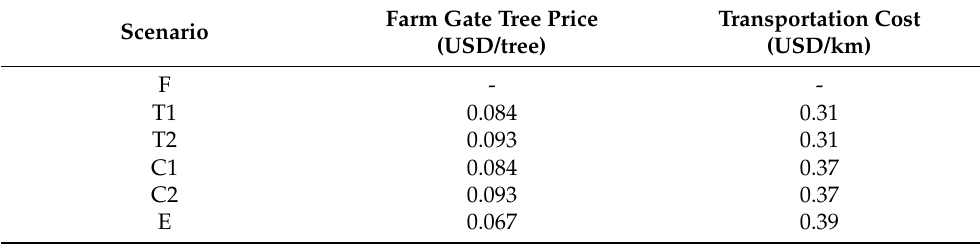
Table 3. Selected rates of farm gate tree price and transportation cost for different